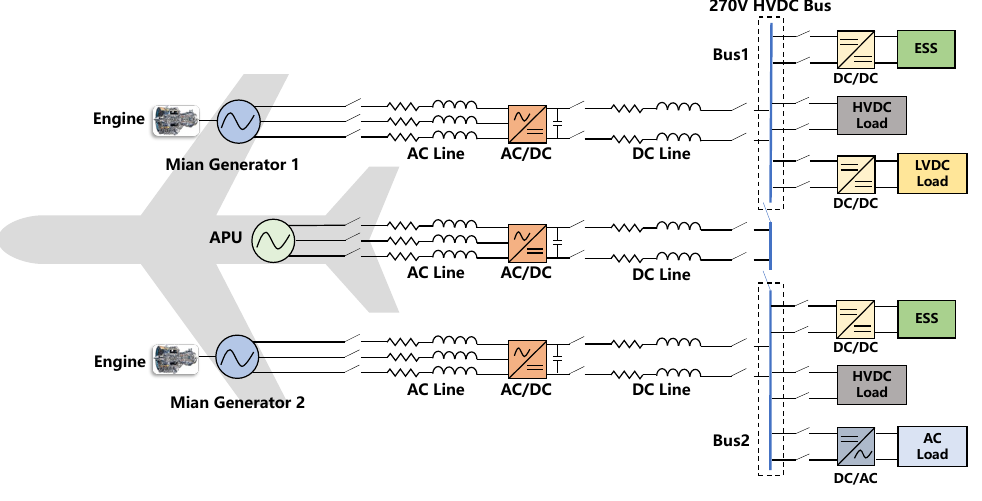
Figure 1. Power system architecture of MEA.